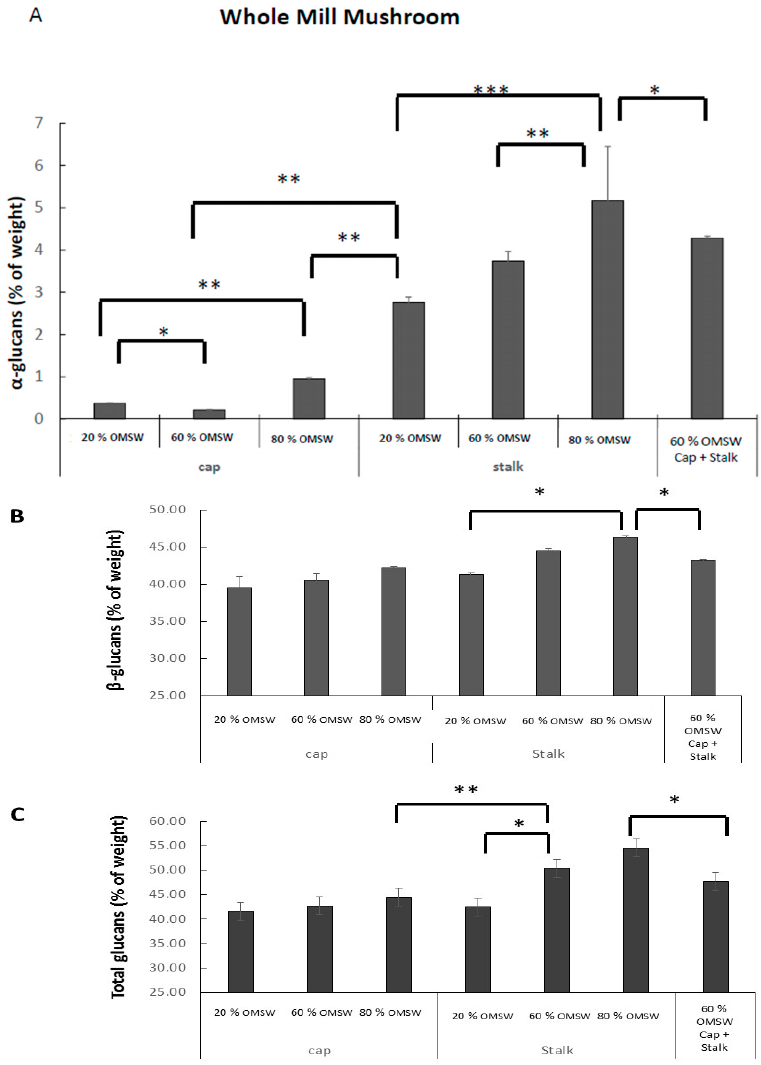
Figure 3. α ( A ), β ( B ), and total ( C ) glucan concentrations in whole mill mushrooms prepared from caps and stalks from Pleurotus eryngii mushrooms cultivated in various relative amounts of eucalyptus sawdust and OMSW. * p < 0.05; ** p < 0.01; *** p <